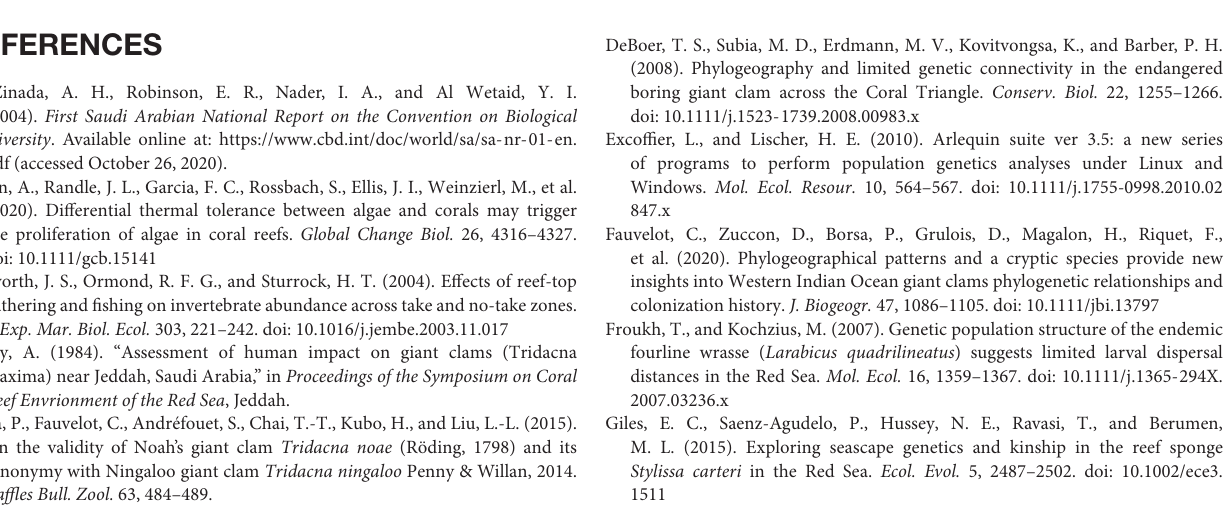
Supplementary Figure 1 | Alignment of eight T. squamosina mtCOI sequences showing the two specimens sharing the same point mutation site on the 51st position.